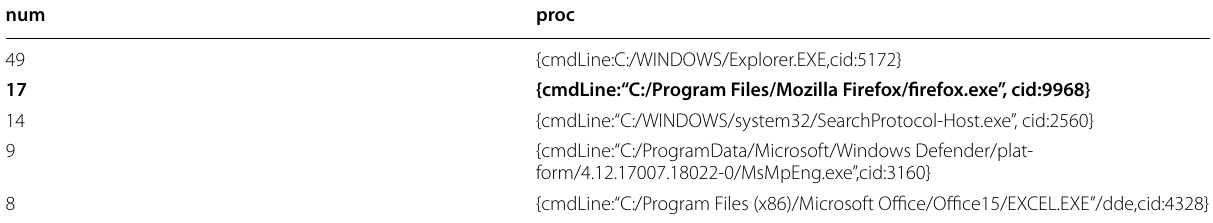
Table 6 Counting of reading user documents